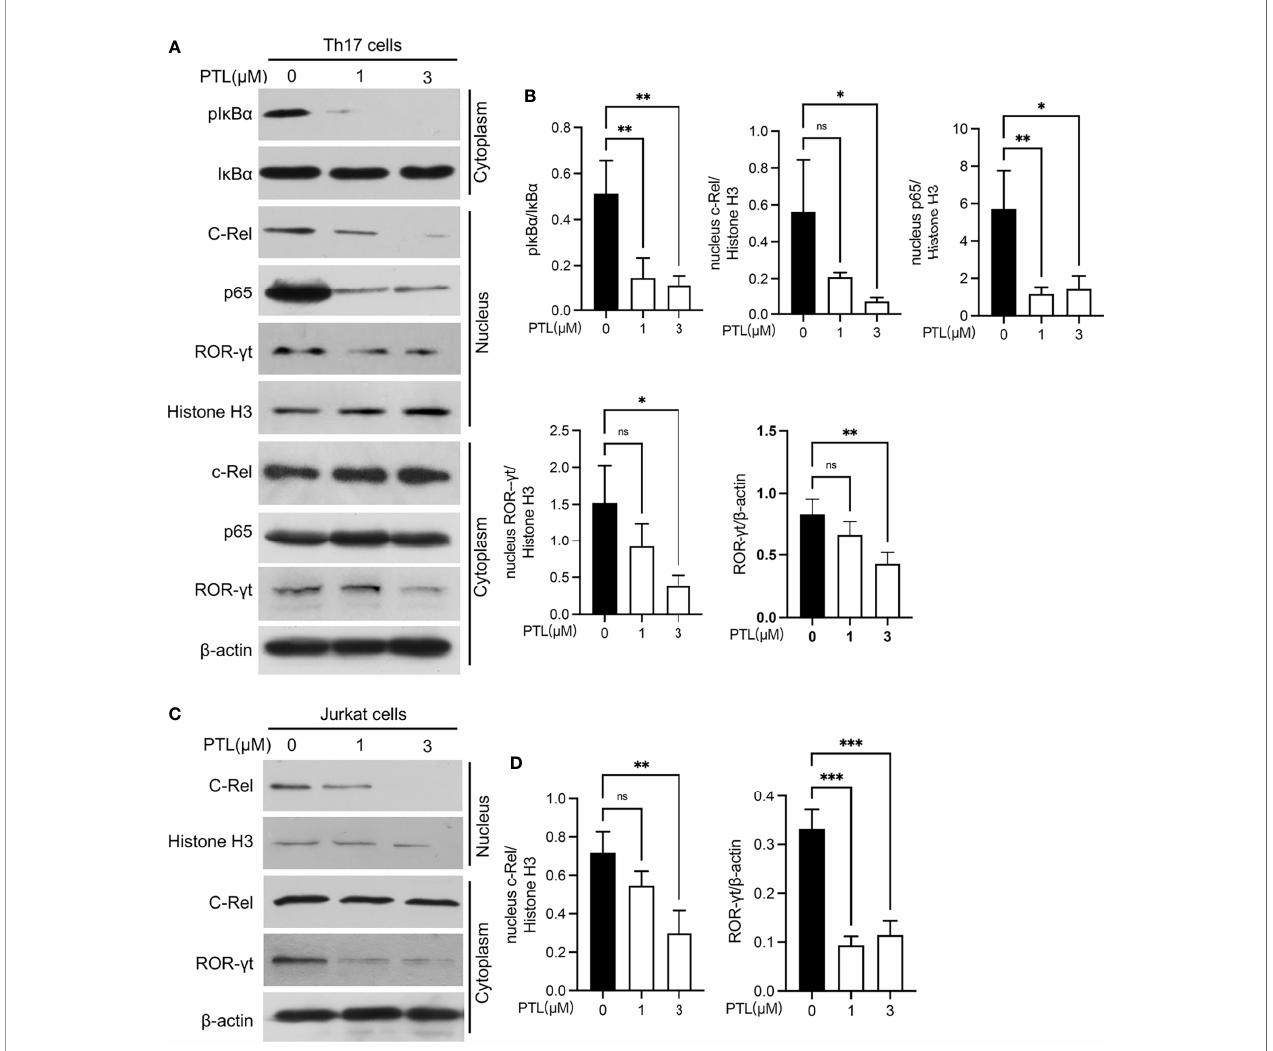
FIGURE 6 | PTL inhibited Th17 differentiation through suppressing the NF- k B pathway. (A) Naïve CD4 + T cells were sorted from spleen and lymph node and polarized in Th17 condition with PTL (0,1 and 3 m M) for 48 h The expression of phosphorylated I k B a , I k B a , c-Rel, p65, and ROR- g t in the cytoplasm or nucleus was determined by Western blot. (B) The statistical results of Western blotting gray values from three independent repeated experiments were calculated. (C) Jurkat cells were treated with PTL (0, 1, and 3 m M) for 24 h. The expression of c-Rel and ROR- g t in cytoplasm or nucleus was detected by Western blot. (D) The statistical results of Western blotting gray values from three independent repeated experiments were calculated. The error bars shown were the mean ± SD. * p < 0.05, ** p < 0.01, ***p < 0.005 using unpaired Student ’ s t -test. ns means “ not signi fi cant ”